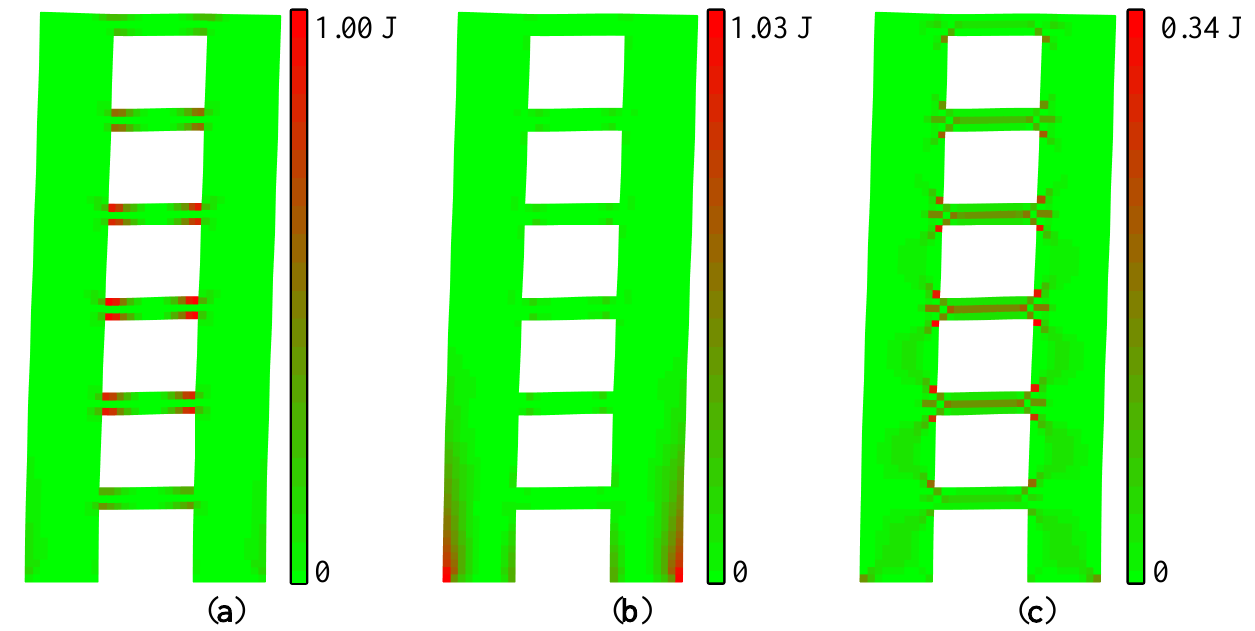
Figure 11. Modal strain energy cloud diagram of first-order vibration mode: ( a ) X-direction modal normal strain energy, ( b ) Y-direction modal normal strain energy, and ( c ) modal shear strain energy.